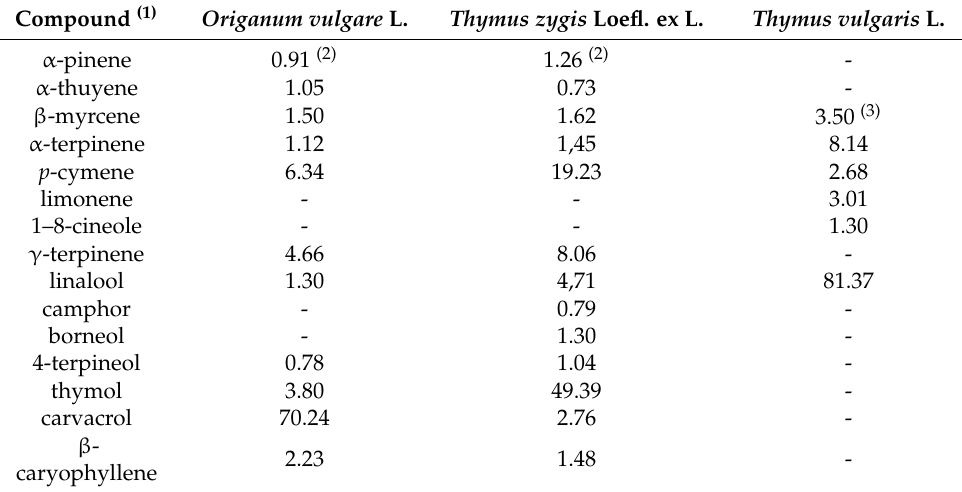
Table 2. Chemical composition of the three essential oils determined by gas chromatography, with detection by mass spectrometry (GC/MS), flame ionization detection (GC/FID), or proton nuclear magnetic resonance (NMR) of the oils in deuterated chloroform. Data provided by the producer (Esencias Mart í nez Lozano, Murcia,